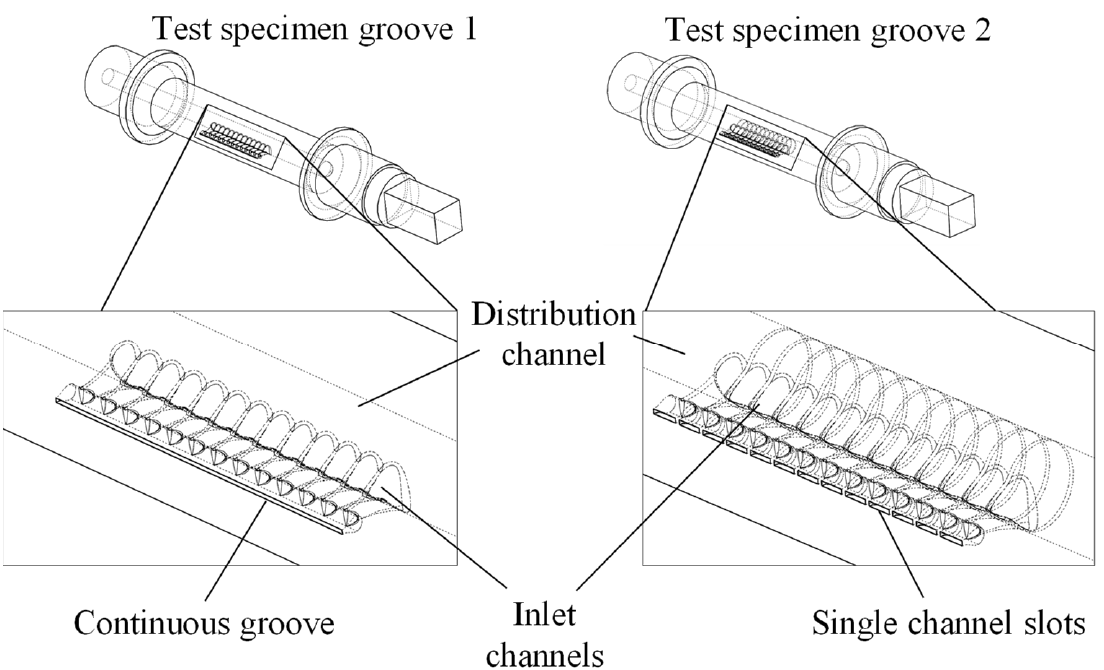
Figure 16. Cylindrical test specimen with different channel outlet openings for hydraulically lubri- cated strip drawing tests.